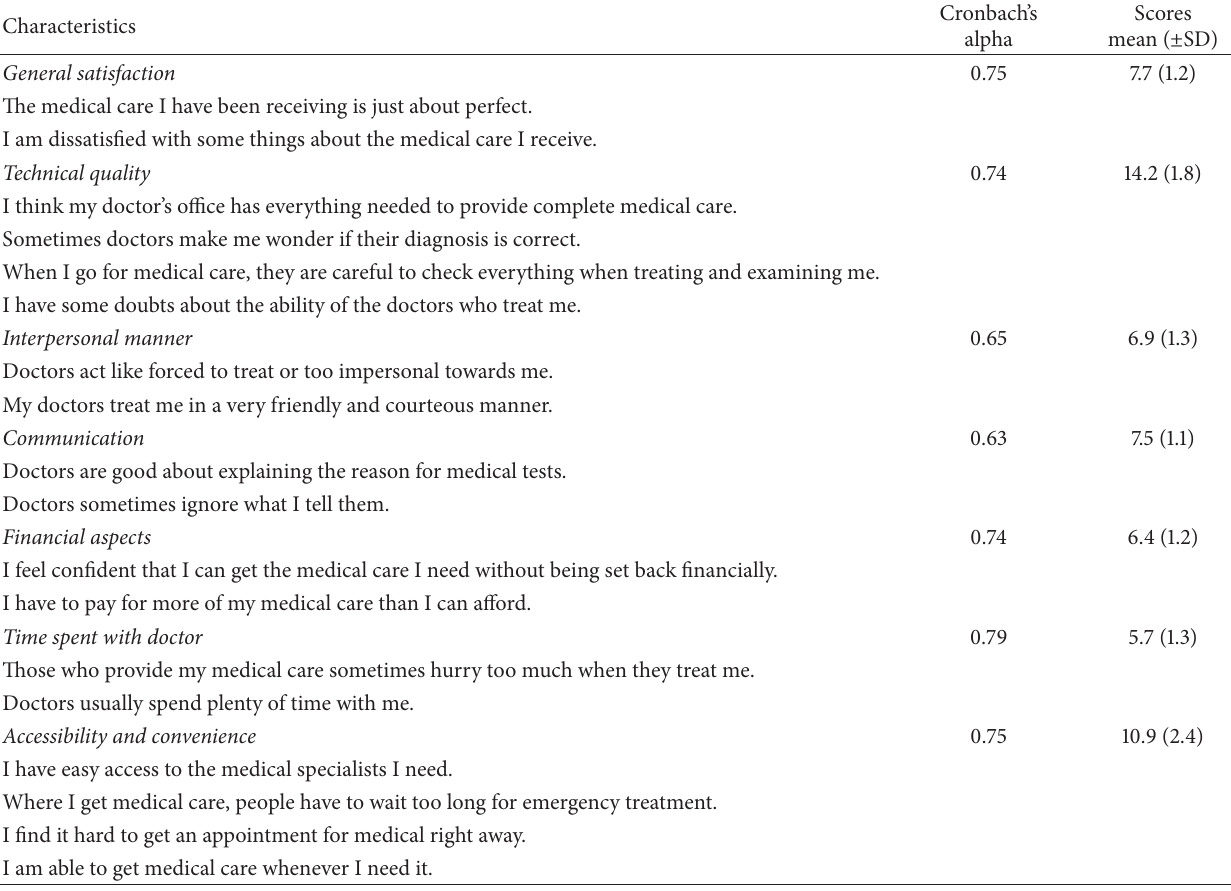
Table 2: Subscale reliability of PSQ-18 and health service satisfaction scores ( 𝑛 =